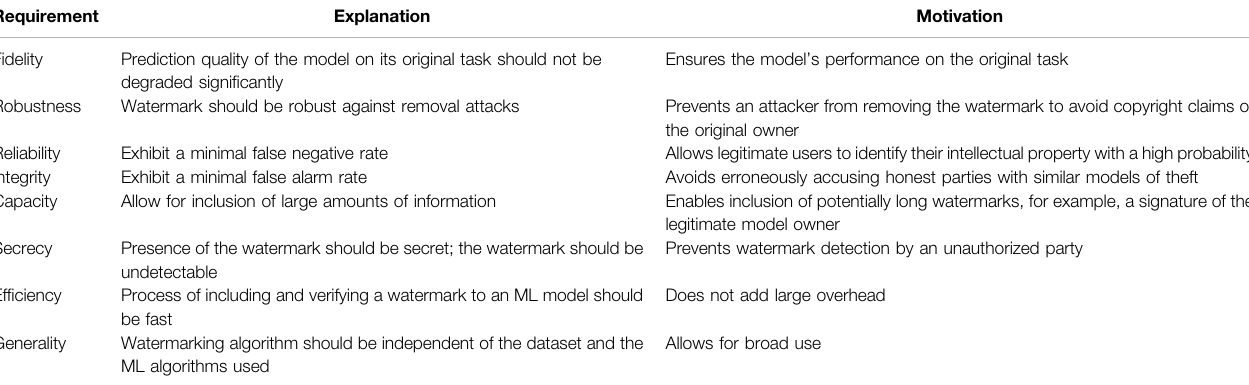
TABLE 1 | Requirements for watermarking